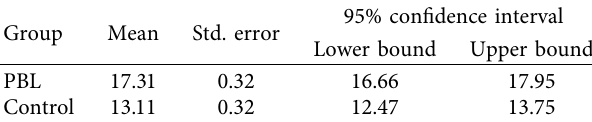
Table 6: Descriptive statistics in